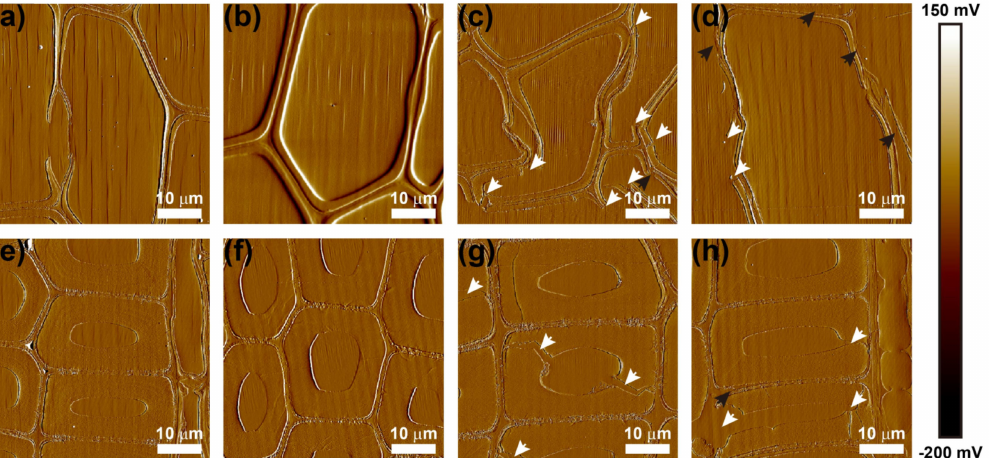
Figure 3. AFM images of cross-sections in recent larch woods and ancient architectural woods. ( a ) The earlywood of SRW. ( b ) The earlywood of HRW. ( c ) The earlywood of OAW. ( d ) The earlywood of IAW. ( e ) The latewood of SRW. ( f ) The latewood of HRW. ( g ) The latewood of OAW. ( h ) The latewood of IAW. The white arrows indicate transverse transwall destruction; the black arrows indicate interfacial